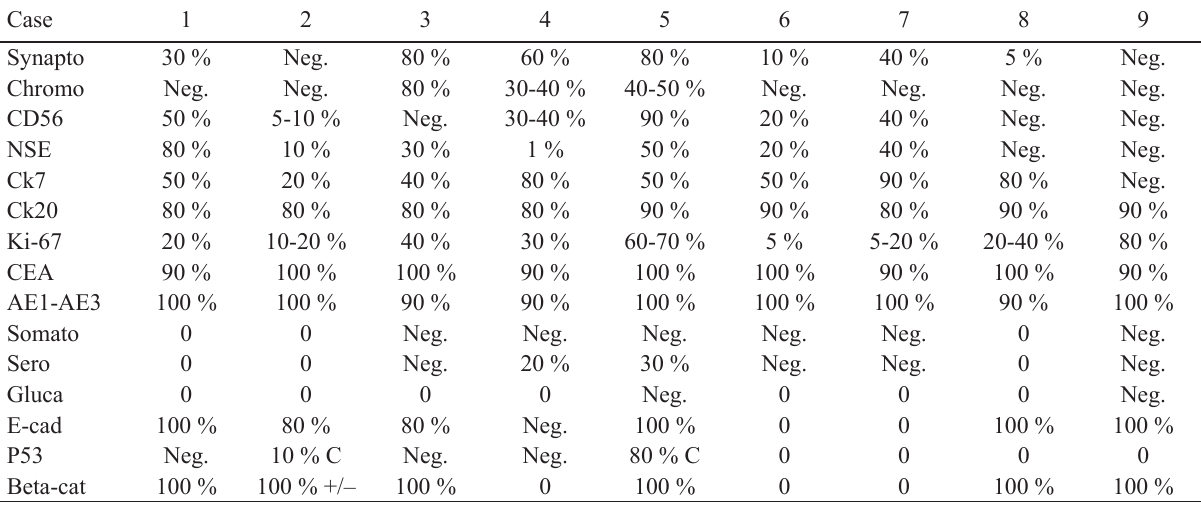
Table 1. Immunoprofile of GCC and adenocarcinoma ex GCC (Nos. 1, 4, 7).